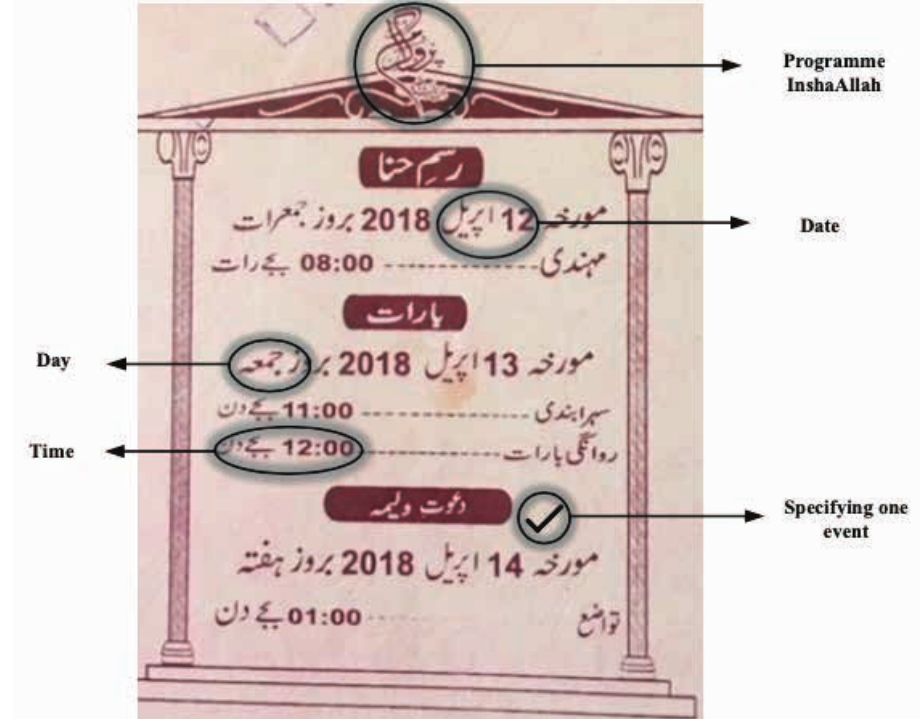
Figure 7: Situating the event: Date, Day,